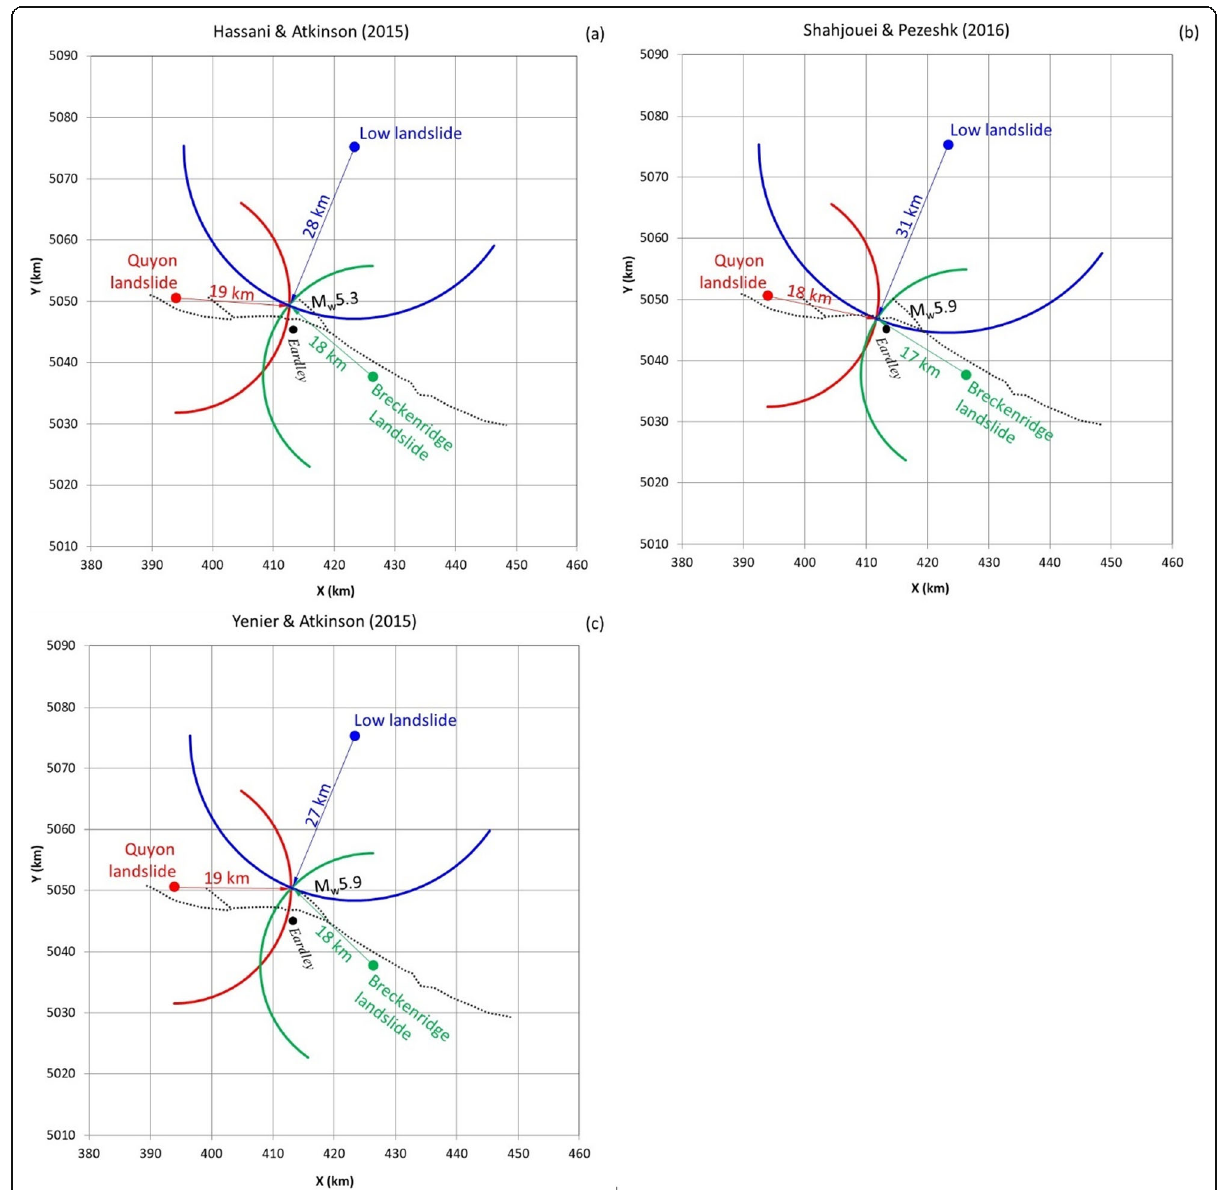
Fig. 10 Earthquake triangulation with three GMPEs: (a) HA15, (b) SP16, and (c) YA15 (Magnitudes are rounded to the first decimal point. Epicentral distances are rounded to the nearest km. Dotted lines mark the nearby Eardley Fault shown in Fig. 1)